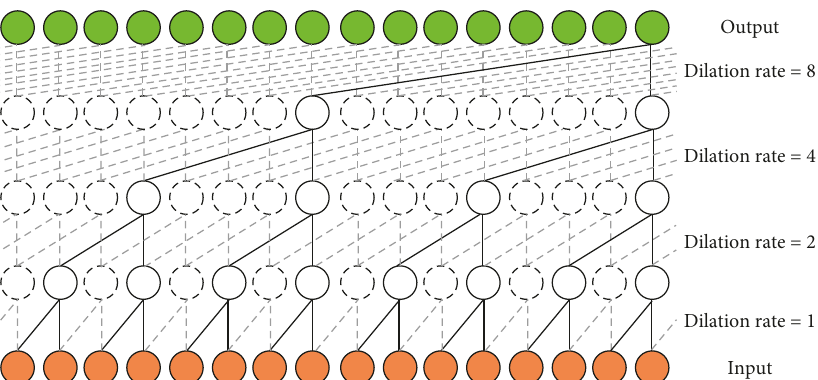
Figure 3: A simple instance of a multiscale one-dimensional causal convolution block. This block includes four multiscale convolutional layers with the filter size of 2, resulting in a receptive field size of 16 for a top-layer node. “Causal” means that each hidden node in this network only obtains information about the past. The dilation rate is 1, 2, 4, and 8 from the bottom to top. The first convolutional layer with dilation rate 1 is an ordinary causal convolutional layer, and other layers with dilation rate greater than 1 could fuse features of multiple time scales.